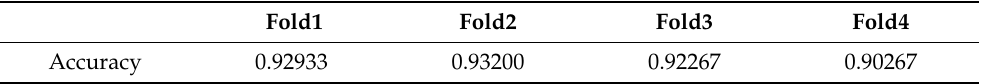
Table 6. Image classification results on grayscaled ASI dataset using Model 6. Fold1 Fold2 Fold3 Fold4 Accuracy 0.92933 0.93200 0.92267